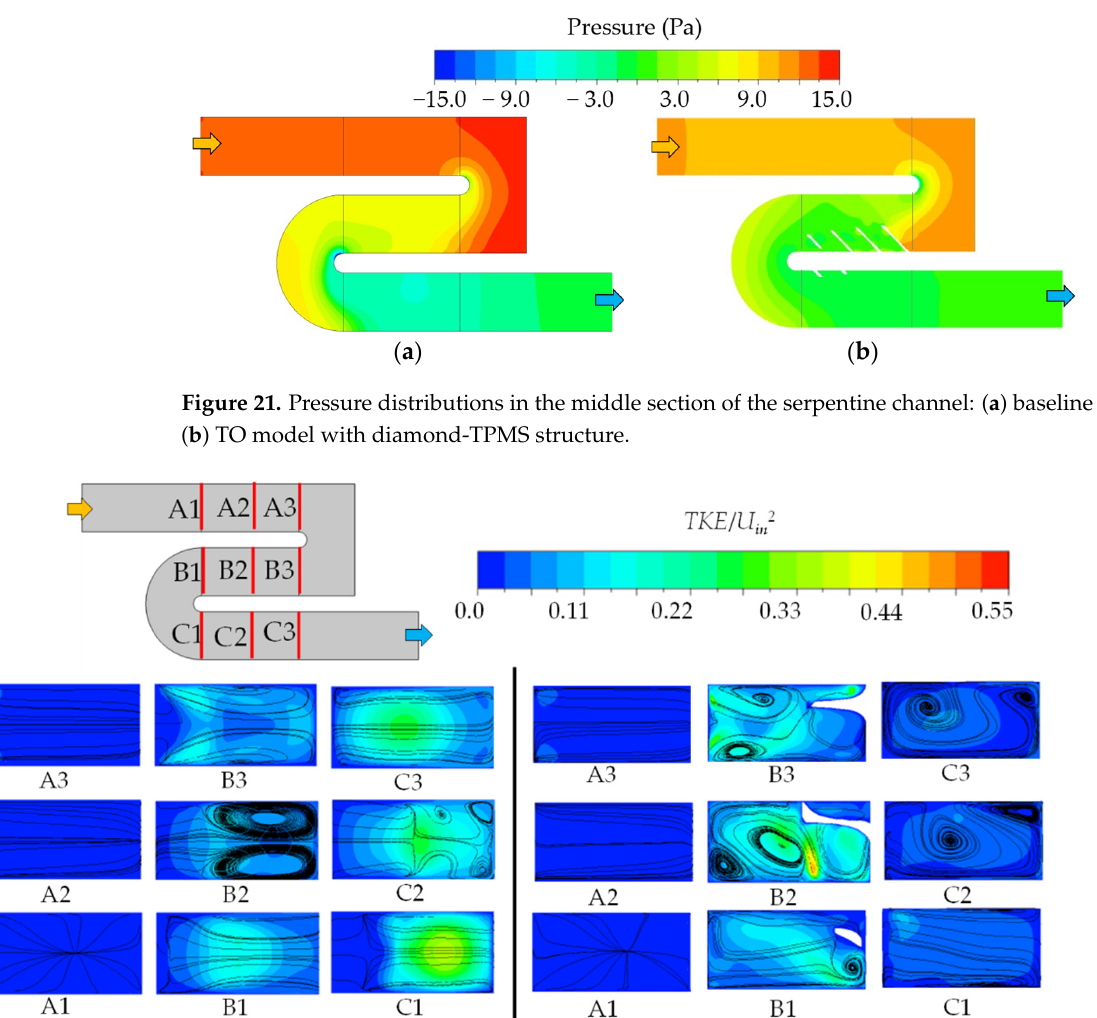
( b ) Figure 20. Velocity distributions and streamlines in the middle section of the serpentine channel: ( a ) baseline model; ( b ) TO model with diamond ‐ TPMS structure. The pressure distribution on the middle section of the channel at the Reynolds num ‐